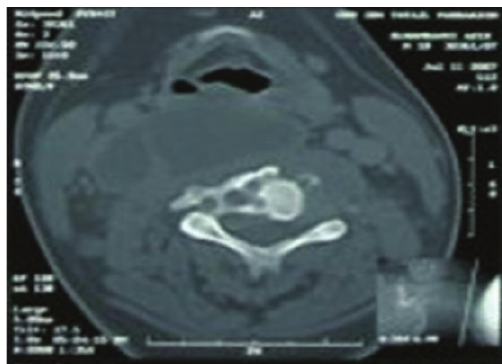
FIGURE 5: Aspect of spondylodiscitis of the fourth cervical vertebra.